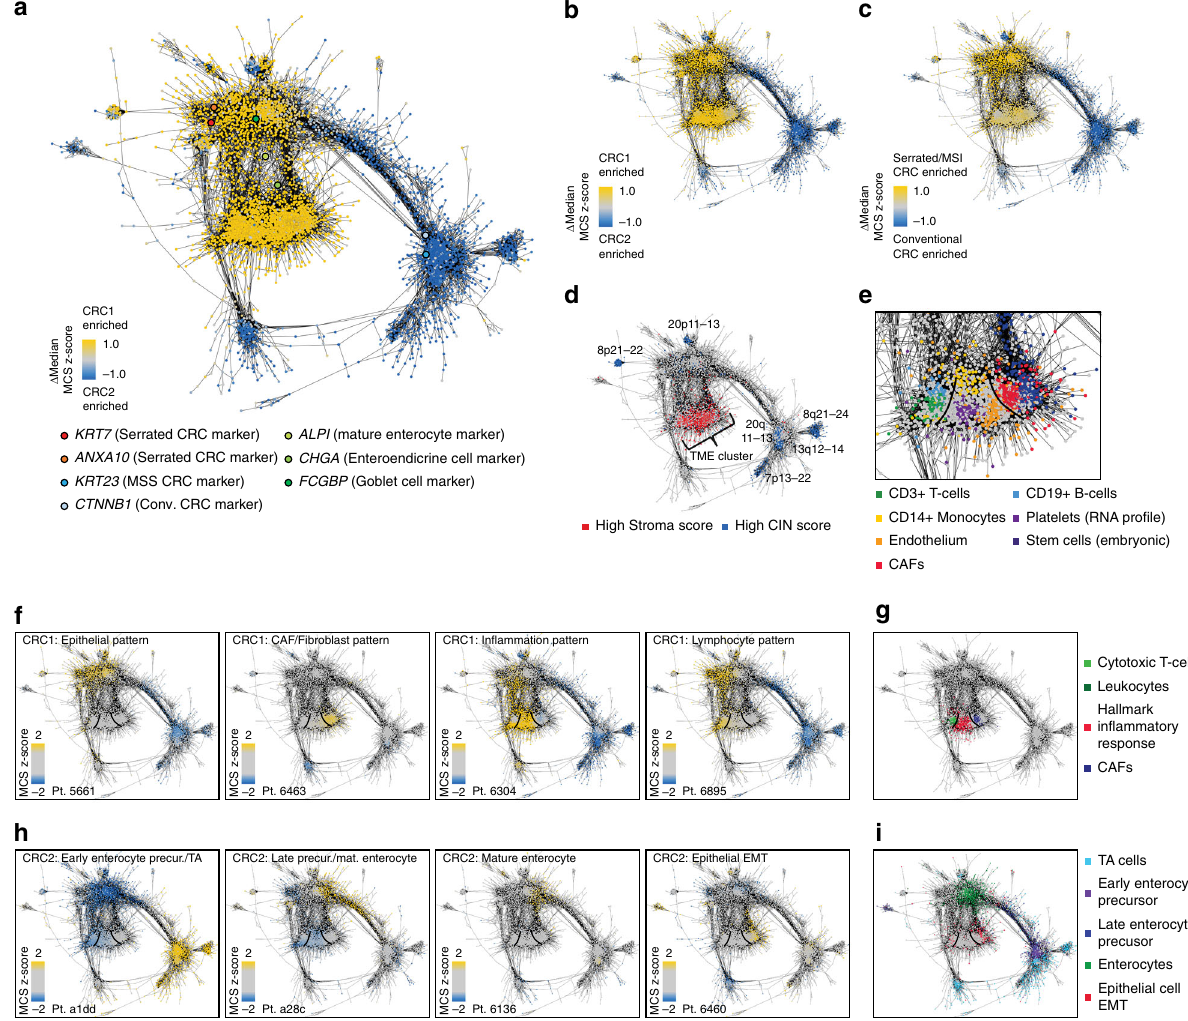
Fig. 3 A MethCORR map identi fi es characteristics of CRC subtypes and intra-subtype heterogeneity. a The MethCORR map is a representation of the MethCORR matrix established by clustering genes (cluster nodes) according to their overlap in expression-correlated CpGs (cluster edges) using Enrichment Map 63 . Each gene is colored according to the difference in median MCS z -scores ( Δ Median MCS z -score) comparing CRC1 and CRC2 within the COREAD FF1 cohort (Supplementary Table 1). Epithelial and CRC-related genes are highlighted by circles. b MethCORR map with genes colored according to Δ Median MCS z -scores comparing CRC1 and CRC2 within the FFPE1 cohort. c MethCORR map with genes colored according to Δ Median MCS z -scores comparing serrated/MSI and conventional CRCs (GSE68060 31 ). d MethCORR map with genes colored according to a high stroma score ( ≥ 0.5 48 ; red) or high CIN score ( ≥ 0.4; blue). A cluster encompassing genes with high stroma scores was named tumor microenvironment (TME) cluster. e Magni fi cation of the TME cluster with genes colored according to high MCS z -scores for either CD3 + T cells, CD19 + B cells, CD14 + monocytes, platelets (RNA pro fi le; MSigDB M7732), endothelium, stem cells (embryonic), or CAFs. MCS z -score pro fi les were calculated within a set of public DNA methylation pro fi les of cell monocultures and tissues (Supplementary Table 4 and Supplementary Data 13). Black lines indicate separation of the TME into lymphocyte, in fl ammation, and CAF/stem cell regions based on differences in cell-type composition. f and h MethCORR maps with genes colored according to the MCS z -scores of representative CRC1 ( f ) and CRC2 ( h ) samples calculated within all samples of the COREAD FF1 cohort. Black lines indicate TME patterns. g MethCORR map with genes colored according to high correlation to median MCS (cMCS) for three gene sets de fi ning either cytotoxic T cells (MSigDB M13247 29 (BioCarta)), leukocytes 48 , hallmark in fl ammatory response 29 , or CAFs 48 ). i MethCORR map with genes colored according to high cMCS for transcriptional gene sets up in either transit amplifying (TA) cells, early enterocyte precursors, late enterocyte precursors, or enterocytes 33 . Genes with >5% increase in MCSs during EMT of epithelial HeLa cells 35 are indicated in red. See methods section for details of Δ Median MCS z -score and cMCS